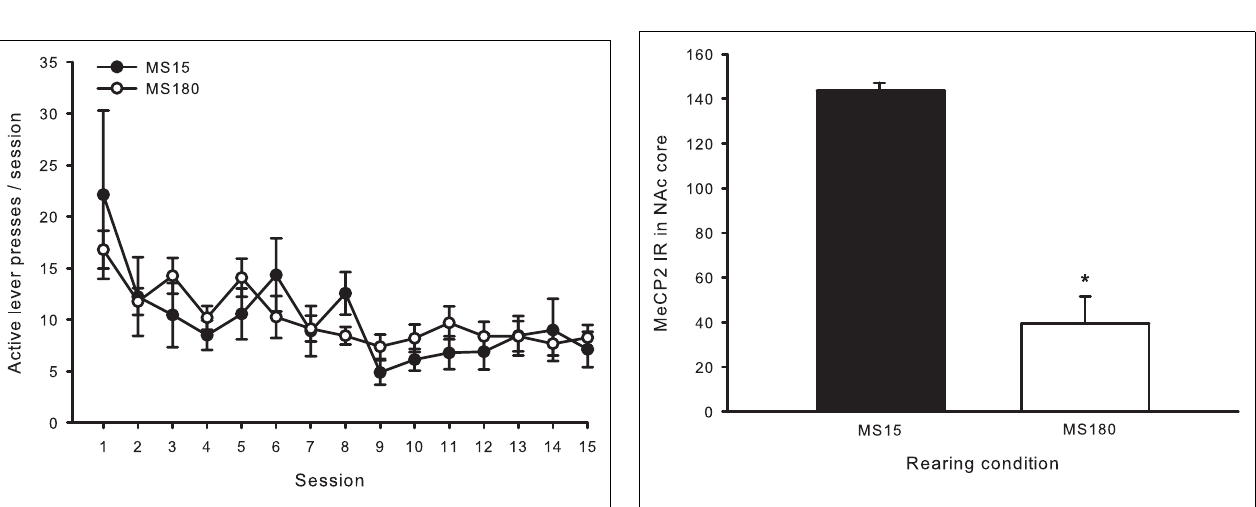
FIGURE 5 | Cell counts for MeCP2 immunoreactivity in the NAc core for MS15 ( n = 5) and MS180 ( n = 5) rats . Data points represent group mean ± SEM. * p < 0.05 vs.